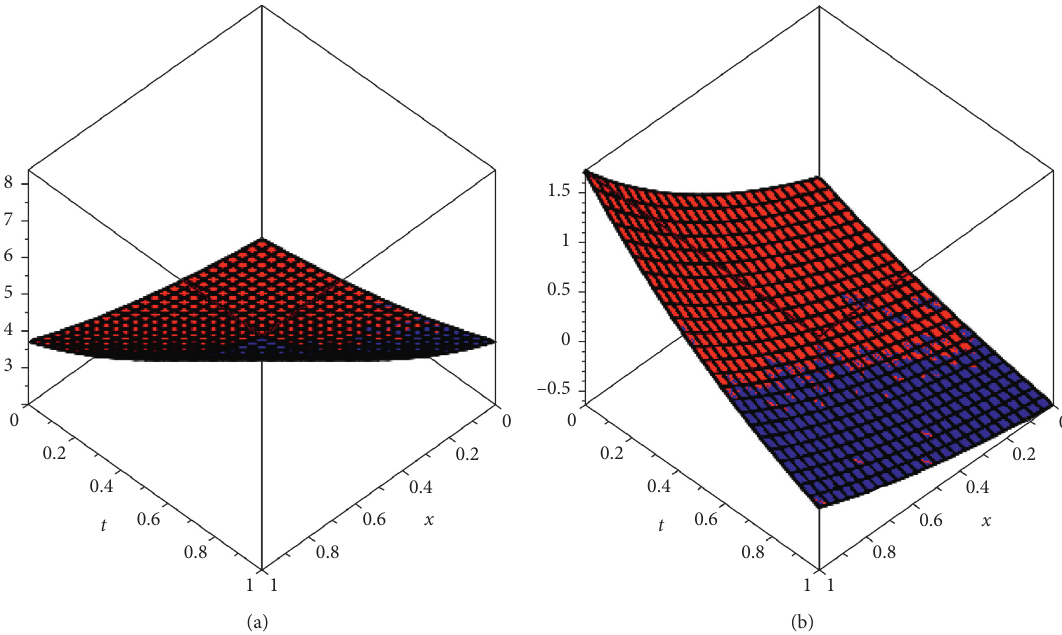
Figure 6: Comparison of the exact solution (blue) and the approximate solutions (red) of Example 6. (a) The solution of w solution of v n ( x, t ) .